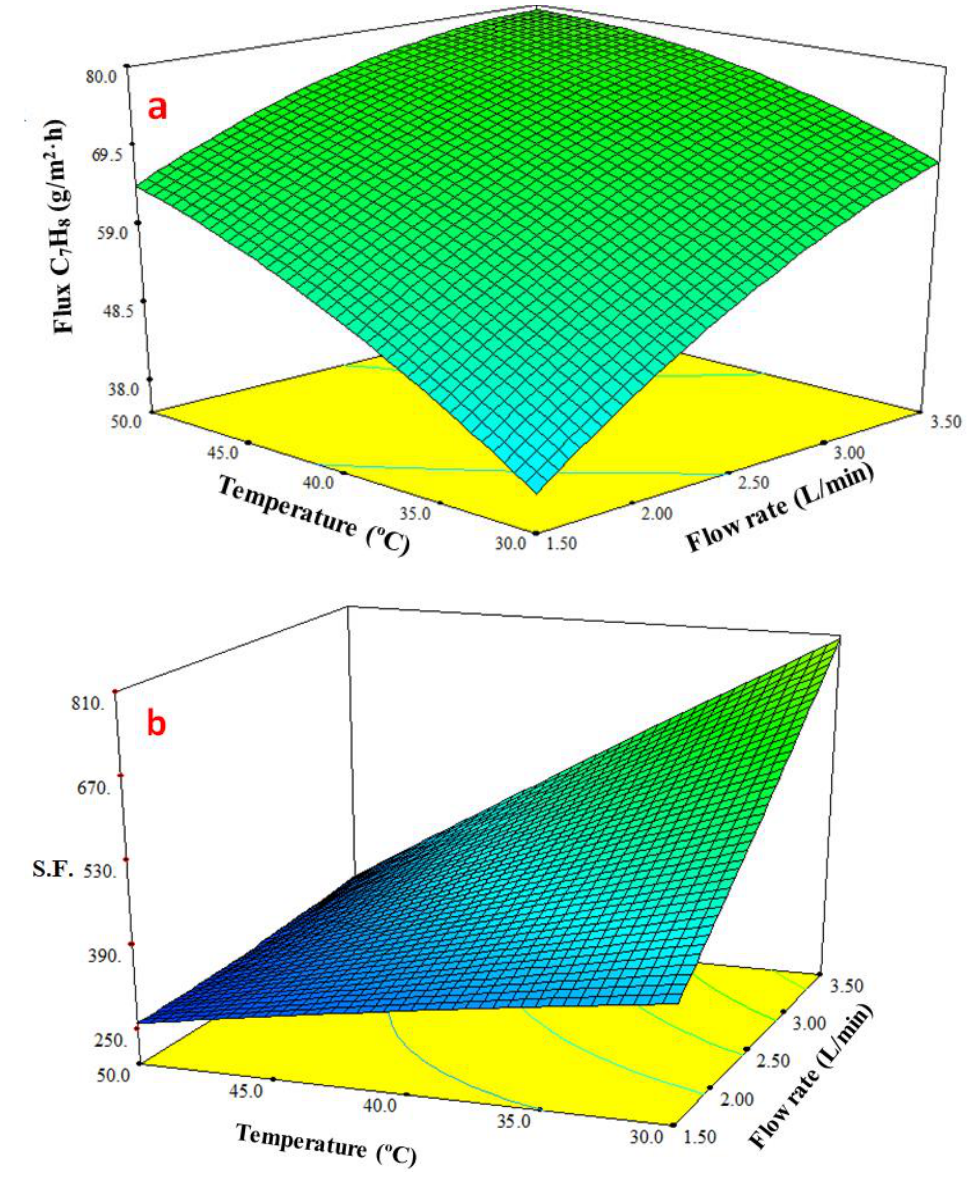
Figure 8. Effect the feed temperature and feed flow on ( a ) toluene flux and ( b ) separation factor ( S.F. ) at a concentration of toluene of 300 ppm.